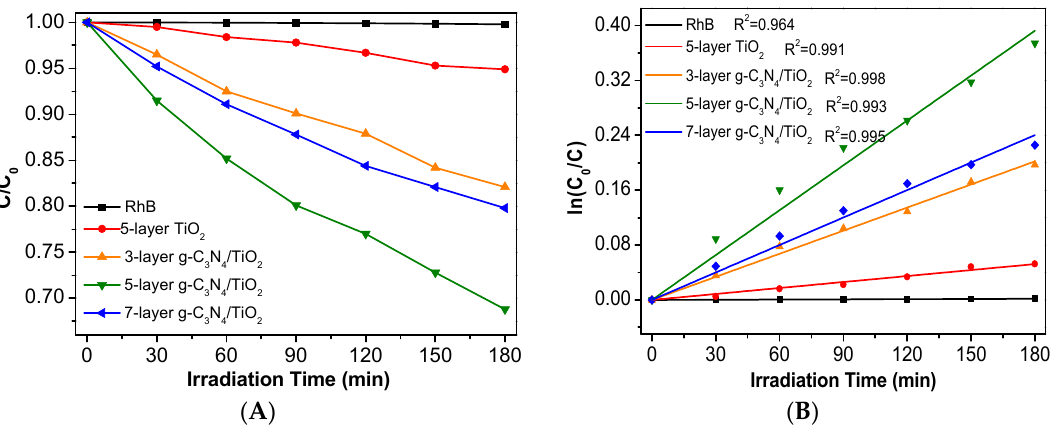
Figure 5. ( A ) Photocatalytic degradation of Rh B by 5-layer TiO 2 and g-C 3 N 4 /TiO 2 thin films with different spin-coating layers. ( B ) The first-order kinetic fitting curve of the photocatalytic degradation.